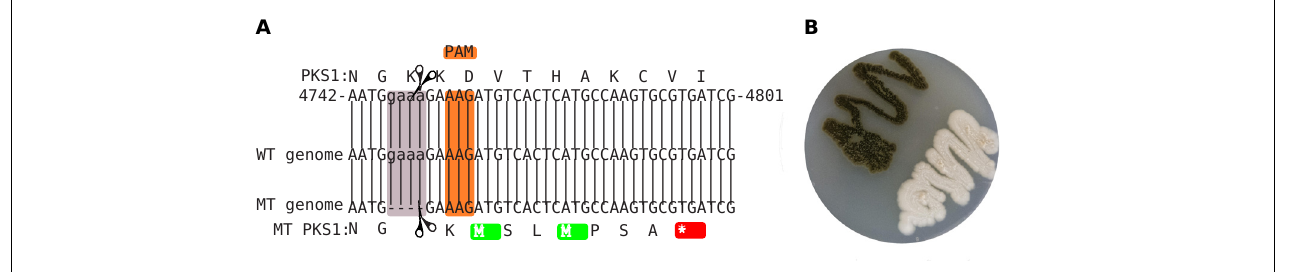
FIGURE 1 | Mutated site in the CRISPR/Cas9-targeted gene. The local PKS1 amino acid and nucleotide sequence in the WT is shown at the top (A) . The sequence of the reference genome is shown in the middle, while the assembled sequence of the mutant is shown at the bottom of the figure. The orange and mauve rectangles highlight the PAM and deleted sequences, respectively. The mutation leads to a stop codon 7 amino acids downstream of the deleted region (red). Culture of the mutant and wild-type strains (B) .